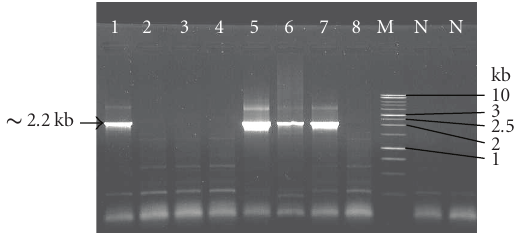
Figure 4: Gel image showing presence of amplified band ( ∼ 2.2 kb) after RT-PCR using Pst I sense and reverse E primer. Lane M: 1kb DNA ladder (Promega, Wis, USA); 1–8: total RNA extracted from new noninoculated leaves of pCG+FSRTRE-derived transcripts from infected plants; N: total RNA of new noninoculated leaves of wild-type transcript from infected plants (negative control).